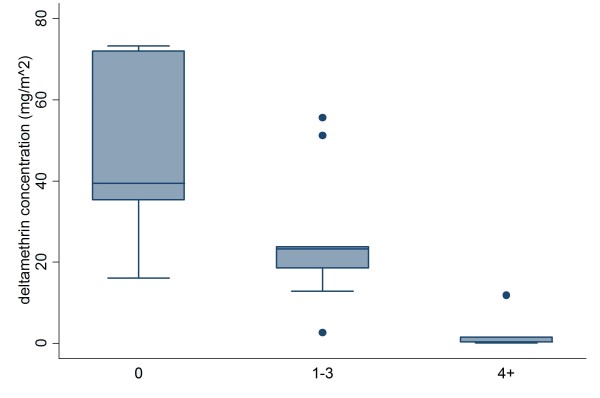
Deltamethrin concentration in the middle sections of nets, sorted by 0, 1-3, and 4+ washes. There was a significant correlation between number of washes and residual deltamethrin concentration (p = 0.001).